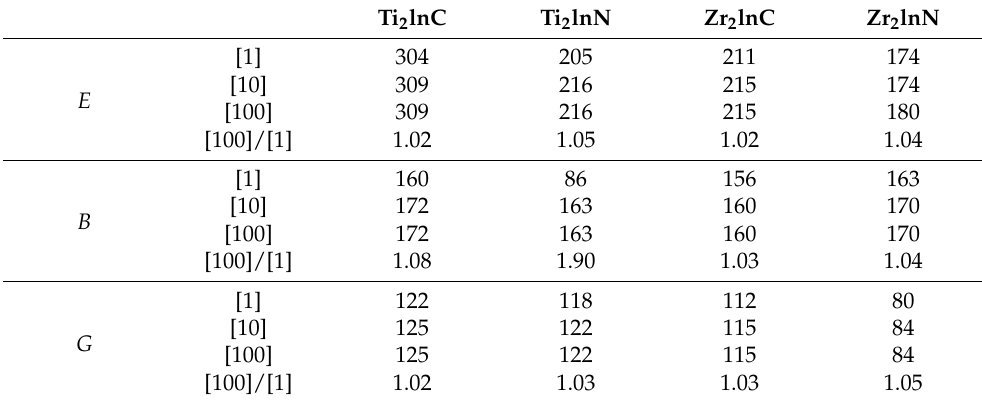
Figure 7. Three-dimensional surface constructions of E ( a , b ), B ( c , d ) and G ( e , f ) of Zr 2 InX (X = C, N) MAX phases. The unit is GPa. Table 5. Calculated uniaxial elastic moduli in the [100], [10] and [1] directions (in GPa) of M 2 InX (M = Ti, Zr and X = C, N) MAX